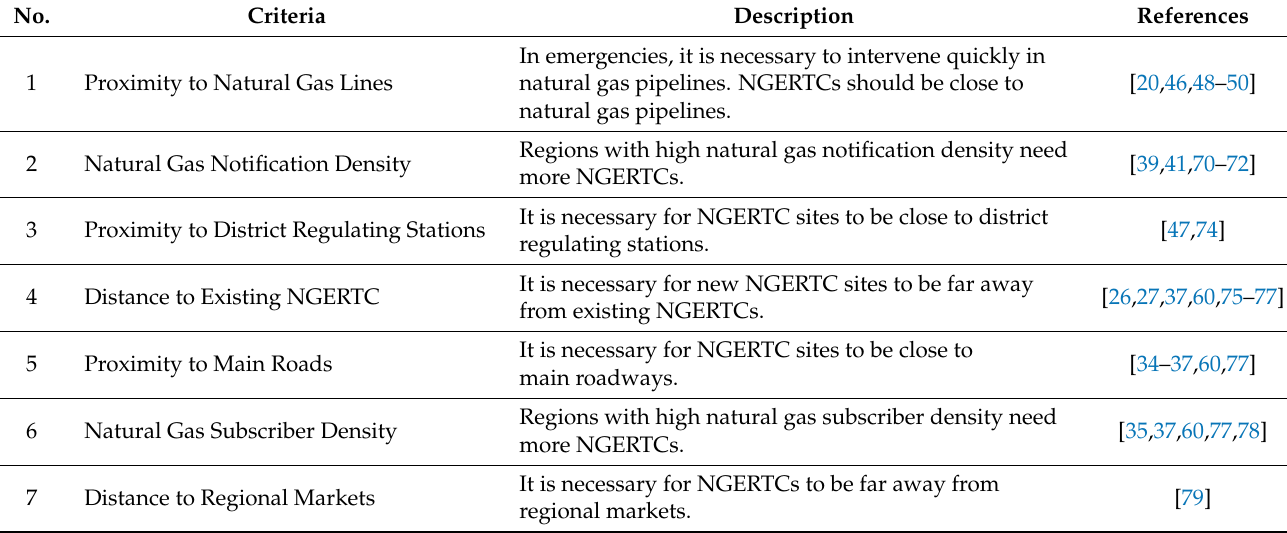
Table 3. Source of criteria data and GIS analysis